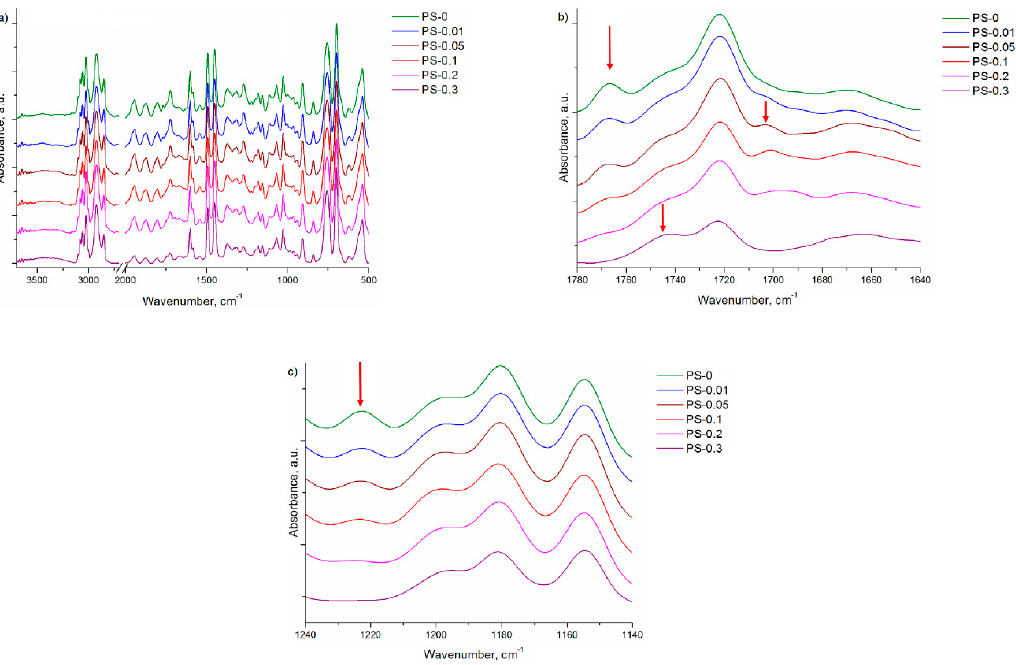
Figure 5. FTIR spectra of PS and PS / rGO beads at di ff erent spectral range: ( a ) 3700–500 cm − 1 ; ( b ) 1780–1640 cm − 1 ; ( c ) 1240–1140 cm − 1 .